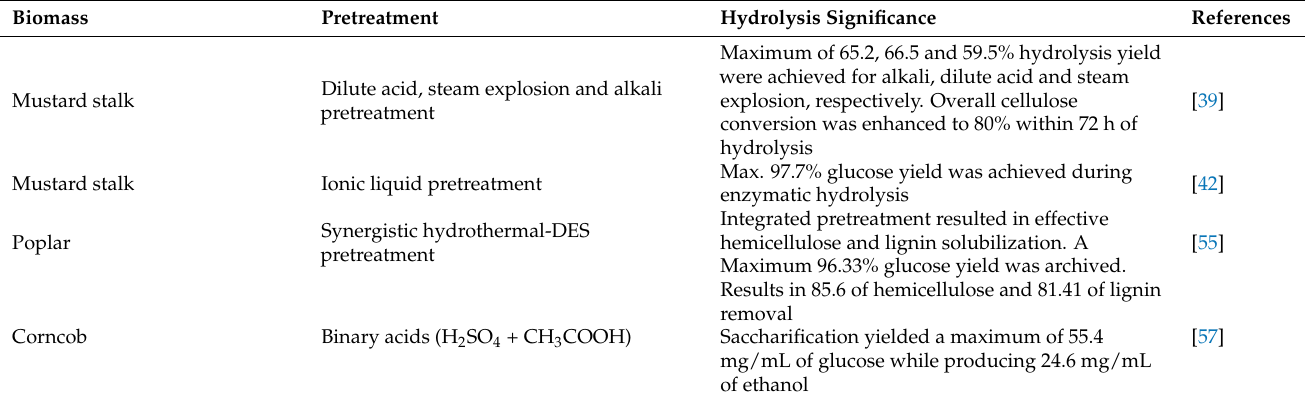
Table 2. Biomass pretreatment and its significance in terms of hydrolysis